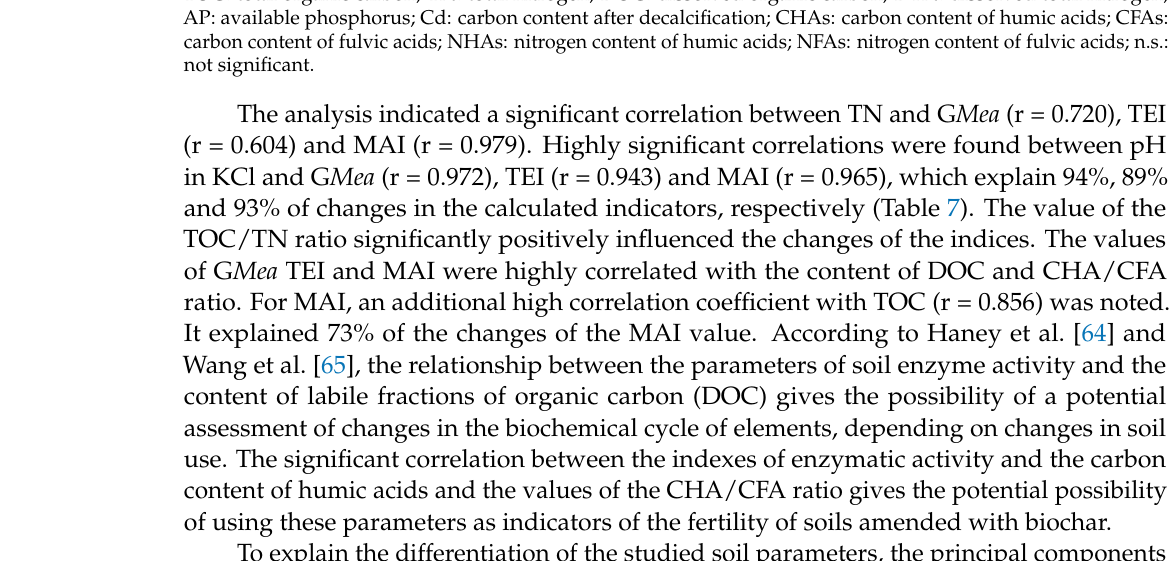
studied parameters (Figure 5). Soil pH was significantly correlated with TN (r = 0.841), DOC (r = 0.977), Cd (r = 0.876), AP (r = 0.668), DEH (r = 0.917), CAT (r = 0.801), AlP (r =